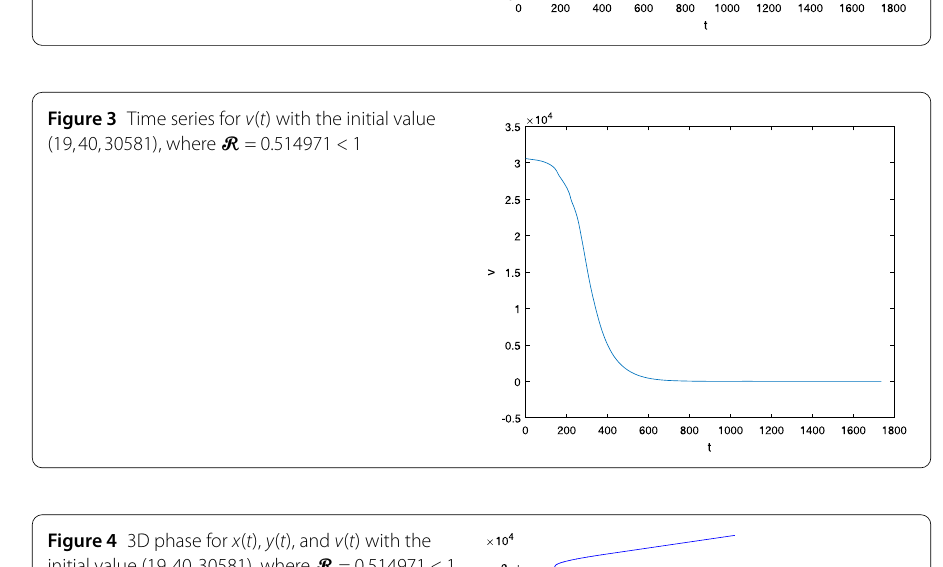
Figure 4 3D phase for x ( t ), y ( t ), and v ( t ) with the initial value (19,40,30581), where R = 0.514971 < 1